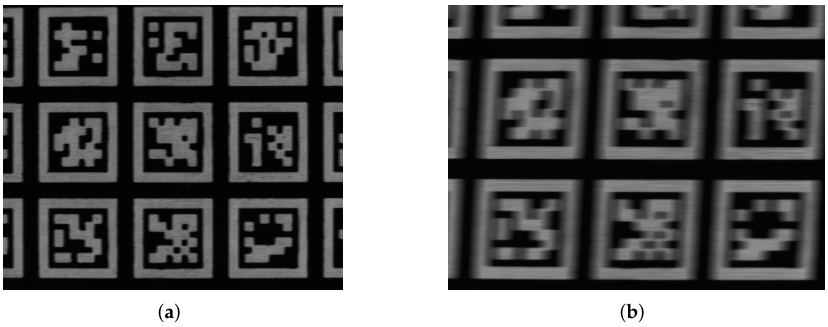
Figure 6. Camera image of moving objects captured ( a ) with a global and ( b ) a rolling shutter. Application Example: Camera System for the H-811